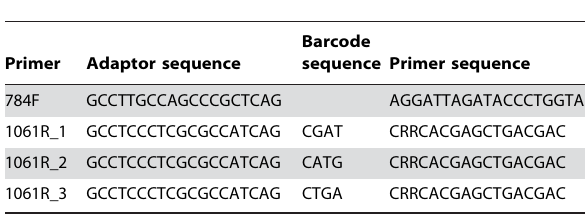
Table 3. Primer, adaptor and sample-specific barcode